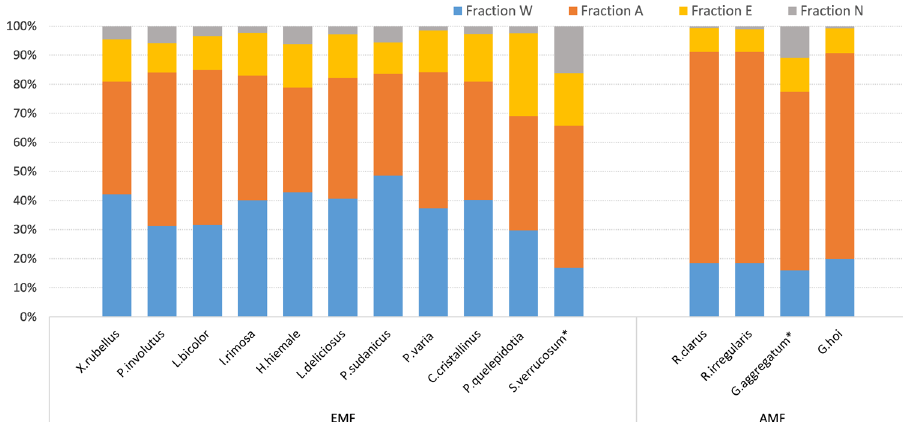
Fig. 1 Chemical fractions of mycorrhizal biomass. Relative abundance of water-soluble (W), acid-hydrolyzable (A), ethanol-soluble (E) and non-extractable (N) components in AM and EM fungi. Mycelia of S.verrucosum * and G.aggregatum * were assessed in a mixture with plant litter (details see Methods section).